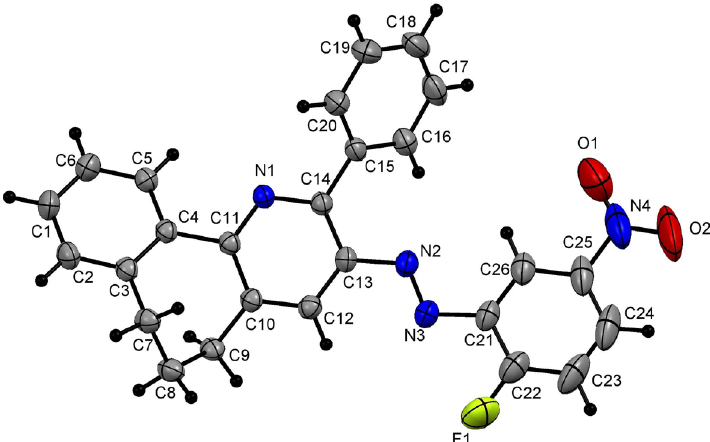
Figure 3. X-ray plot of the crystallographic data collected for 4b . Mercury (version 3.8) (https ://www.ccdc.cam. ac.uk/solut ions/csd-syste m/compo nents /mercu ry/) was used to create this figure.